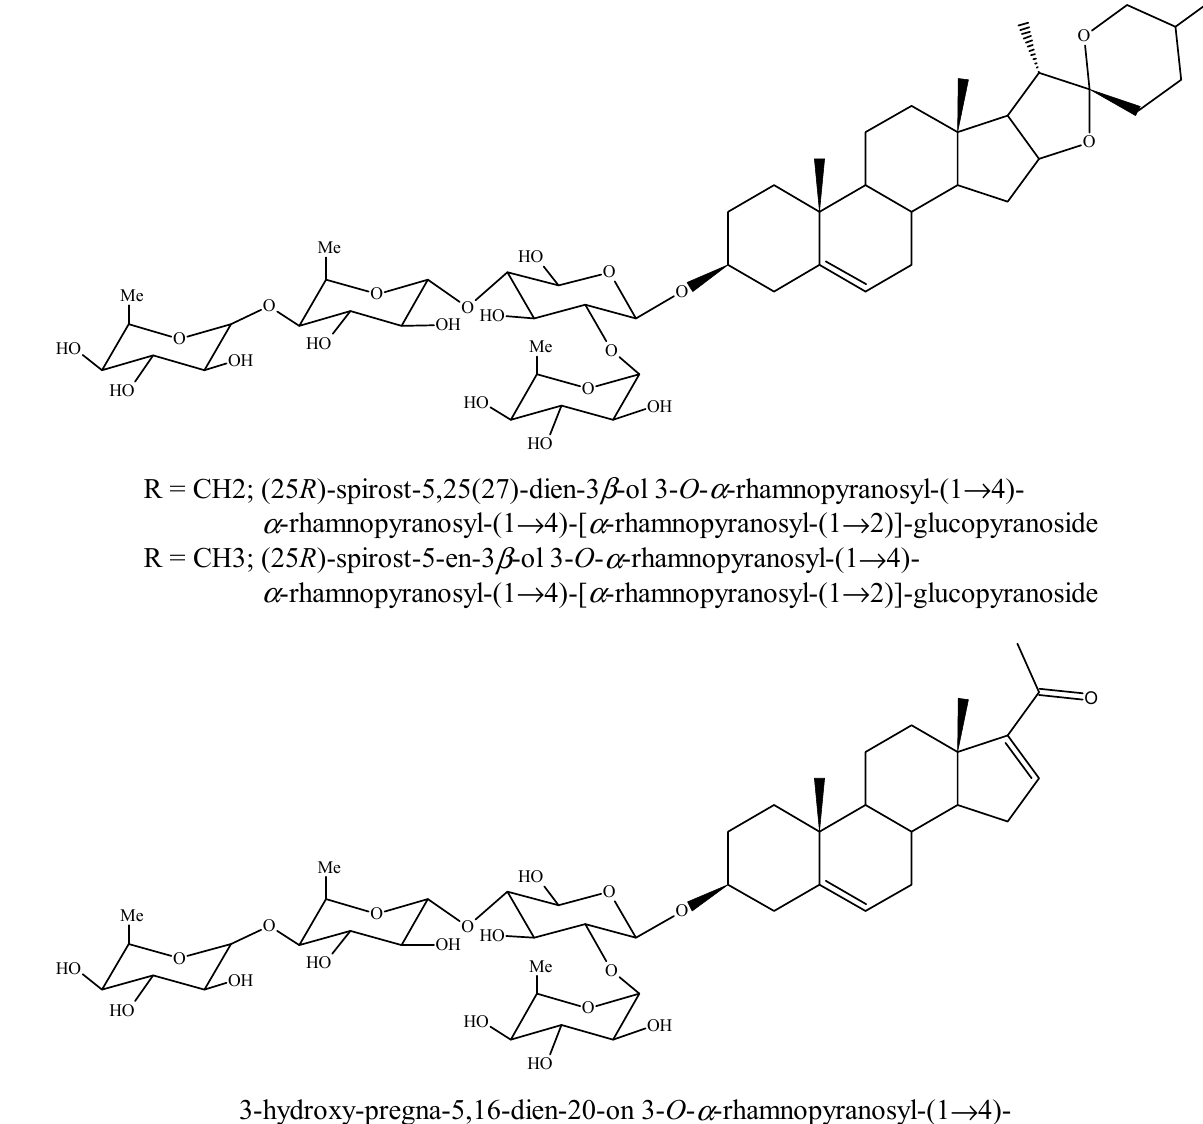
Figure 9. The structures of steroidal glycosides isolated from A . ursinum.